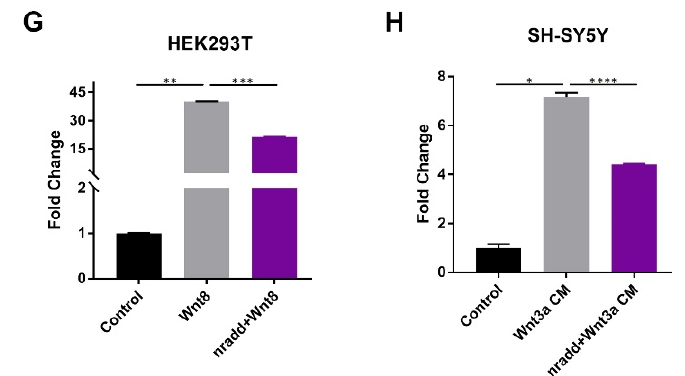
Figure 2. nradd acts as an inhibitor of Wnt/ β -catenin signaling. ( A ) Wnt/ β -catenin reporter activity is reduced in 7xTcf:mCherry embryos injected with 250 pg nradd mRNA. (n (tailbud): control 26/26 embryos, nradd 27/31 embryos; n (10-somite): control 26/26 embryos, nradd 25/26 embryos, n (22 hpf): control 21/21 embryos, nradd 29/30 embryos). Three independent experiments were conducted. ( B ) Classification of phenotypes at 24 hpf caused by wnt8 overexpression in hs:Wnt8a transgenic embryos after 1 hour of heat shock during gastrulation. Class 2: no eyes, reduced forebrain, normal midbrain–hindbrain boundary (mhb, arrow), class 3: no forebrain, severely reduced midbrain, no mhb, class 4: abnormal